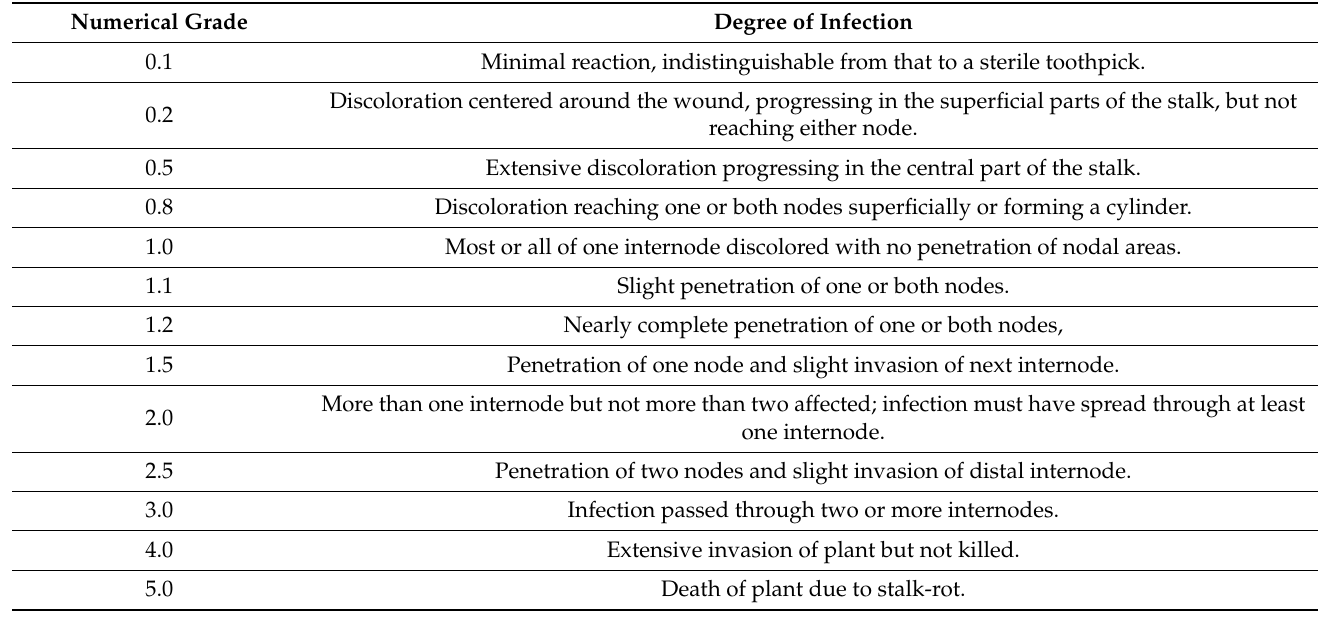
Table 1. Disease rating scale adopted according to IDIN-instruction manual.